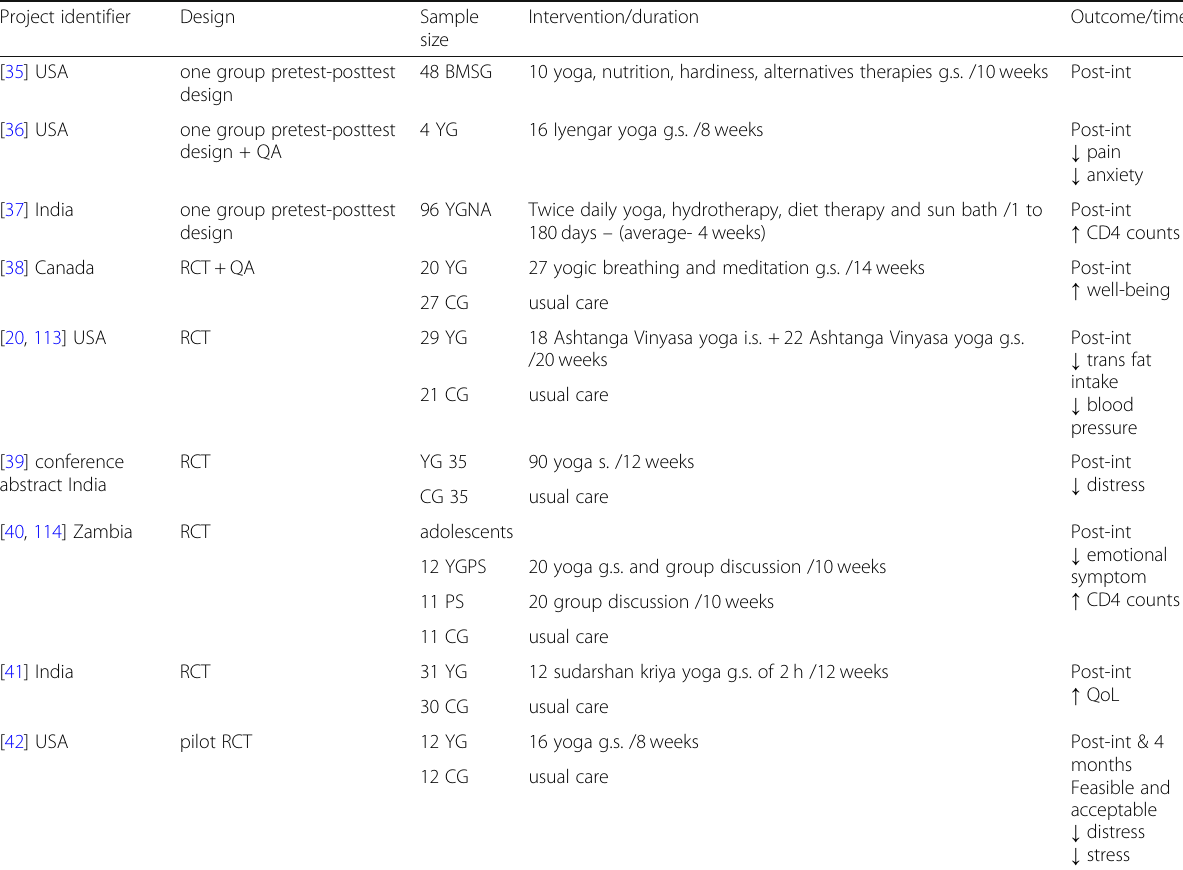
Table 4 Yoga included studies Project